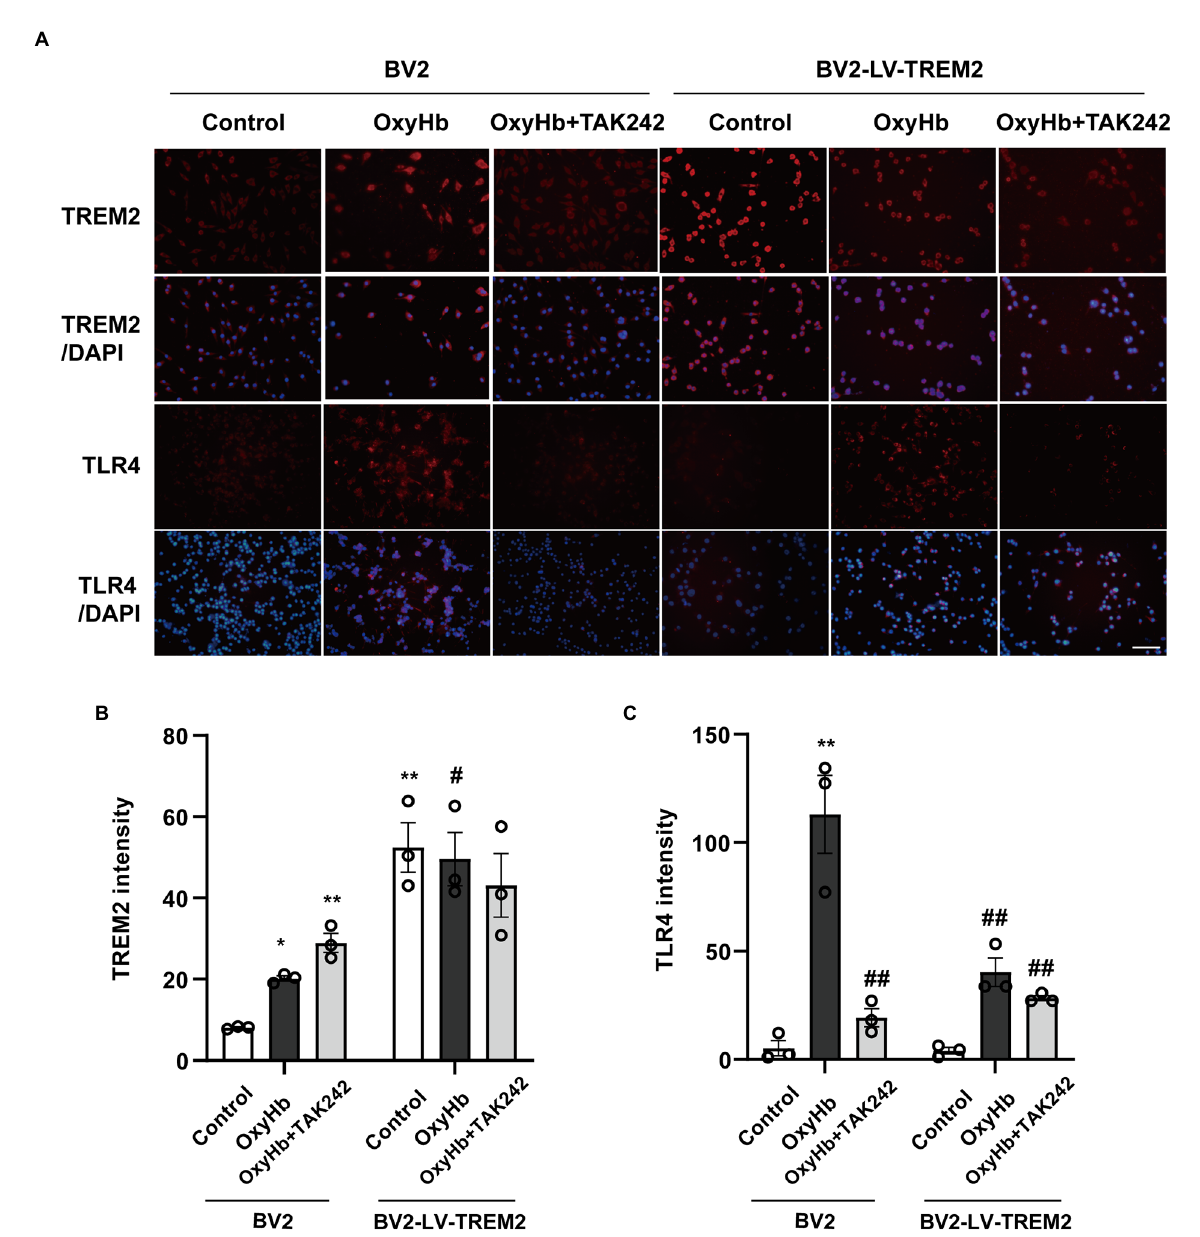
FIGURE 4 The interaction between TREM2 and TLR4 in the OxyHb-induced intracerebral hemorrhage cell culture model. (A) TREM2 and TLR4 immunochemical staining. (B,C) The levels of TREM2 and TLR4 in BV2 cells. * p < 0.05, ** p < 0.01, vs. BV2 control group. # p < 0.05, ## p < 0.01, vs. BV2 OxyHb group. LV, lentivirus; Scale bar: 100 μ m. The data were represented as mean ± SEM. n = 3 per